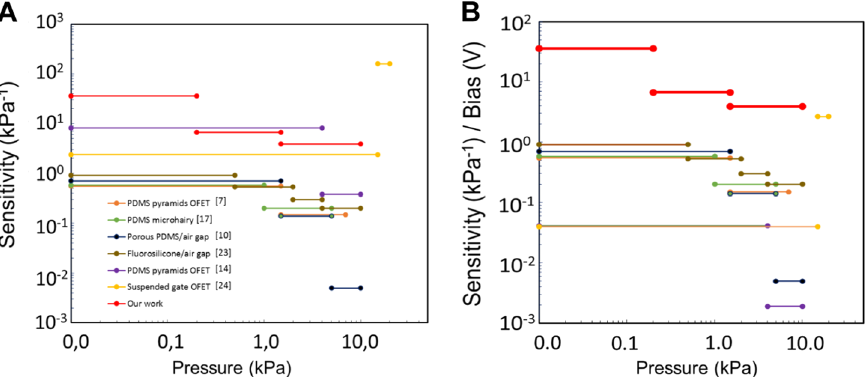
Fig. 5 a Comparison of the sensitivity of capacitive pressure sensors as a function of pressure. The plot includes the values reported from refs. 7,10,14,17,23,24 and from this work. b Sensitivity over the used bias for the same systems as in